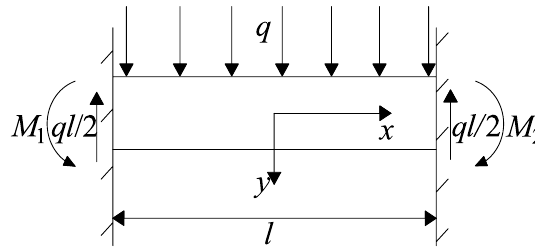
Figure 12. Mechanical model of solid support beam.